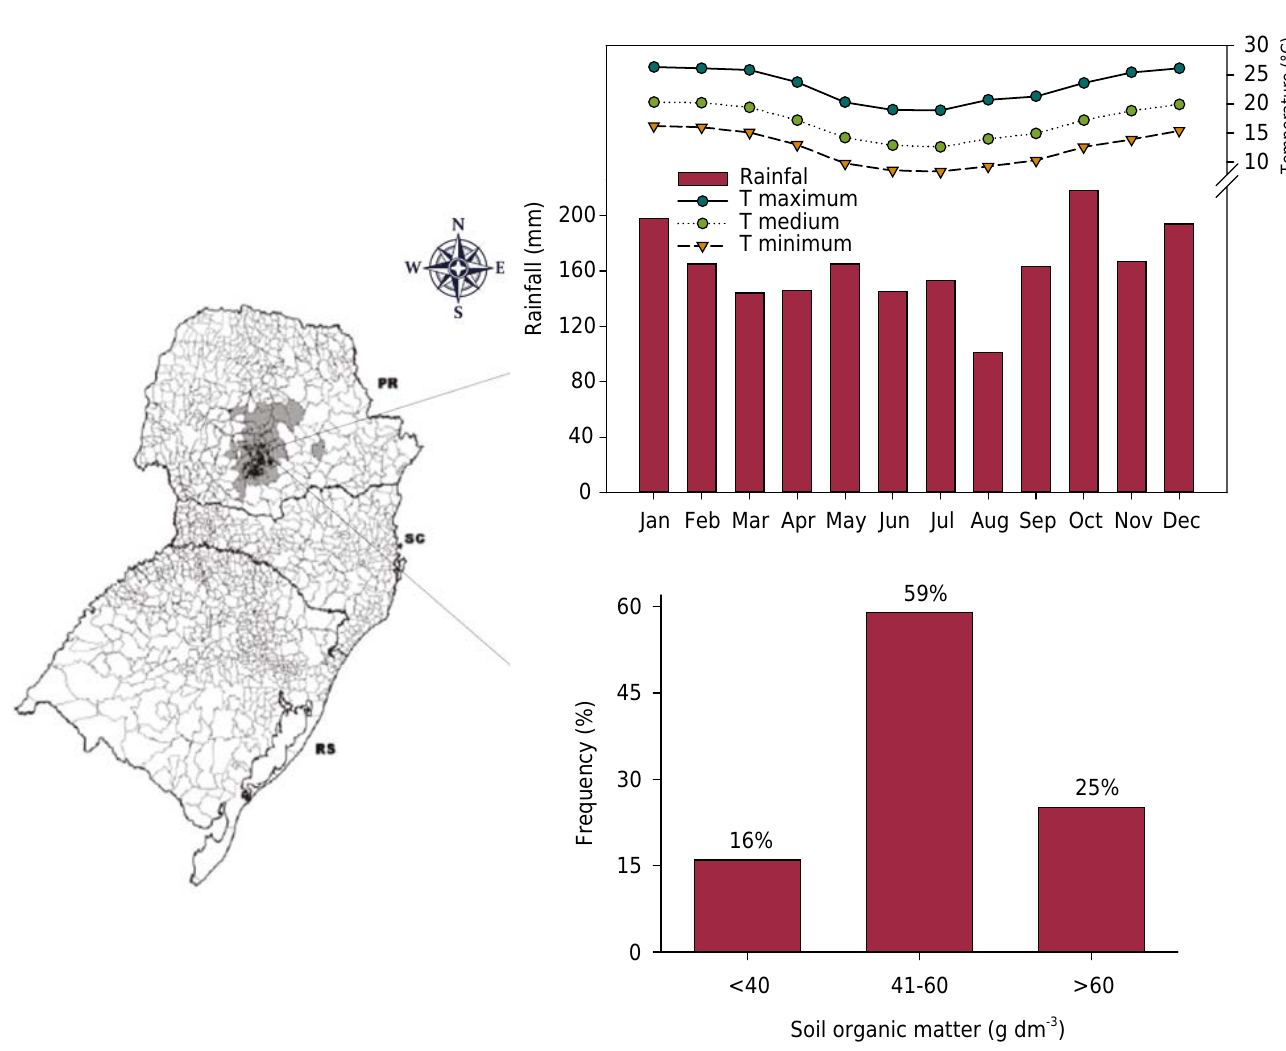
Figure 1. Map of Southern Brazil and South-Central Paraná (in gray), where the experiments of N fertilization of winter cereals were conducted. Monthly rainfall and temperatures (maximum, medium, and minimum), and soil organic matter distribution (Fontoura et al., 2015) are